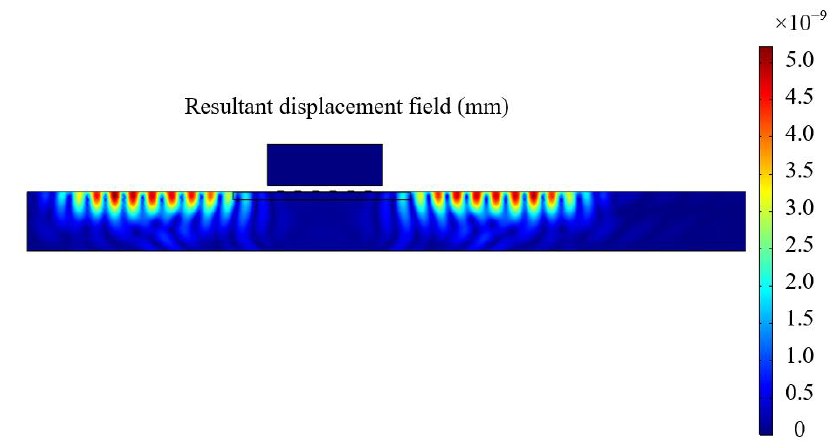
Figure 16. X -direction component of surface wave (in-plane displacement).